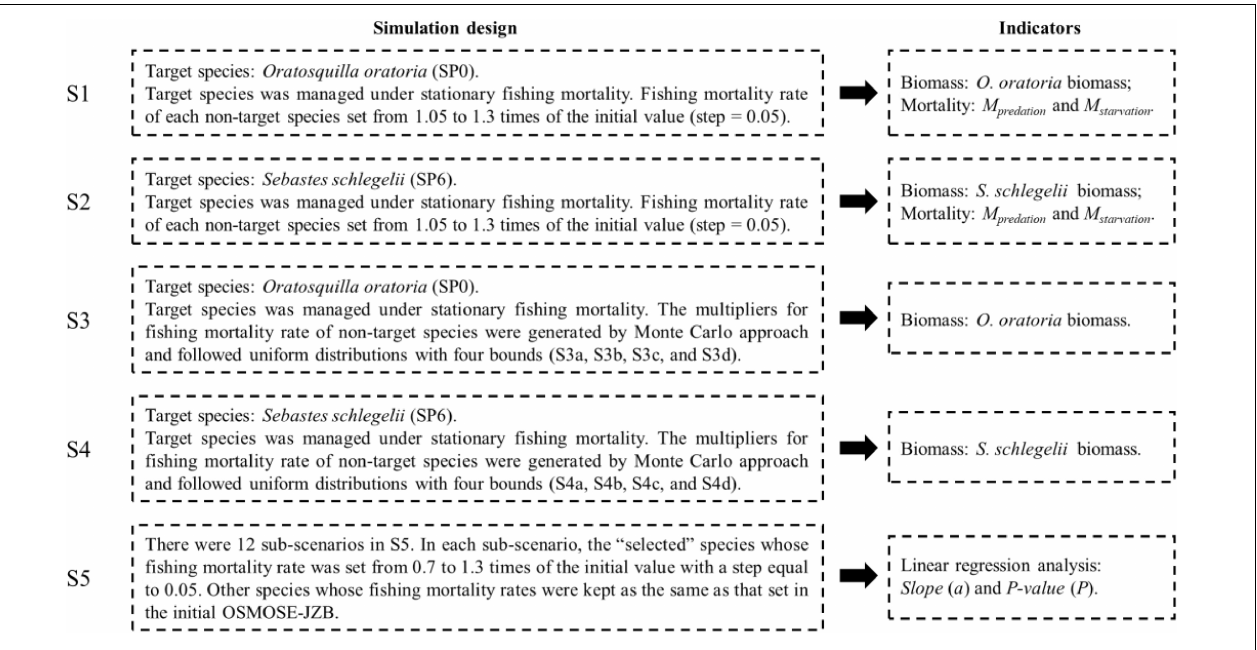
FIGURE 2 | Flow chart of the processes in scenarios S1 to S5.